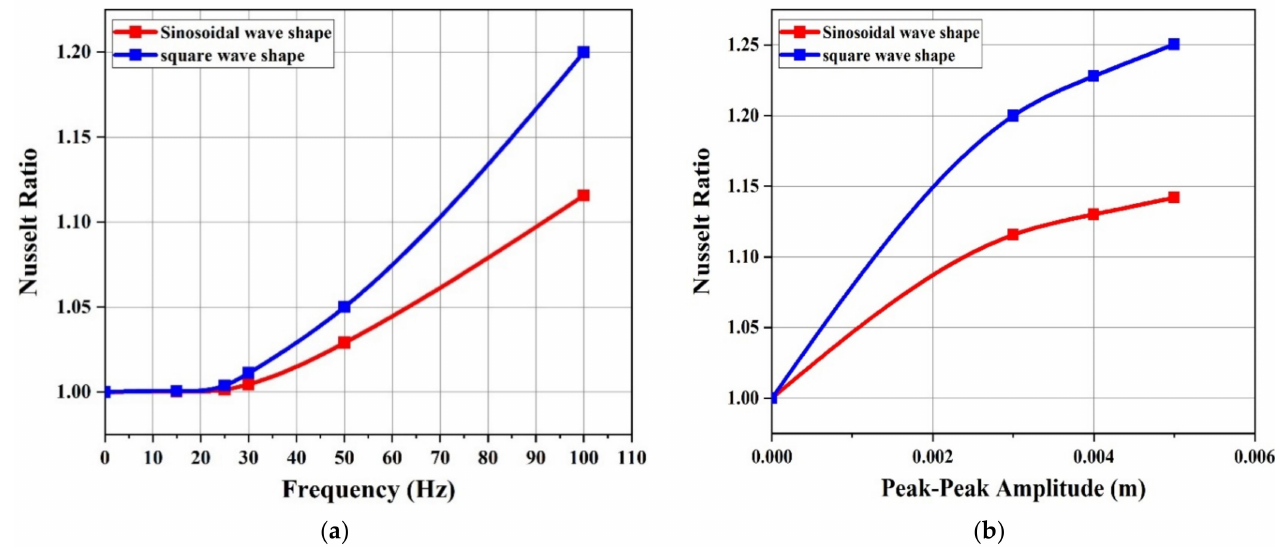
Figure 11. Variation in Nusselt ratio with vibrational parameters at Re = 1000: ( a ) frequency at constant Amp = 0.003 m; ( b ) peak-to-peak amplitude at constant f = 100